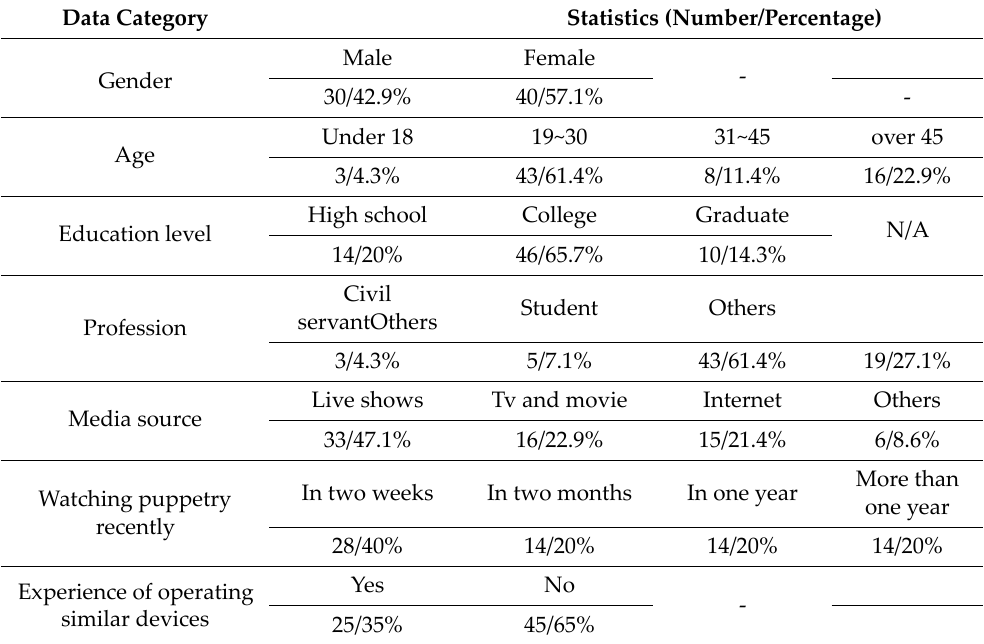
Table 6. Statistics of the basic data of the